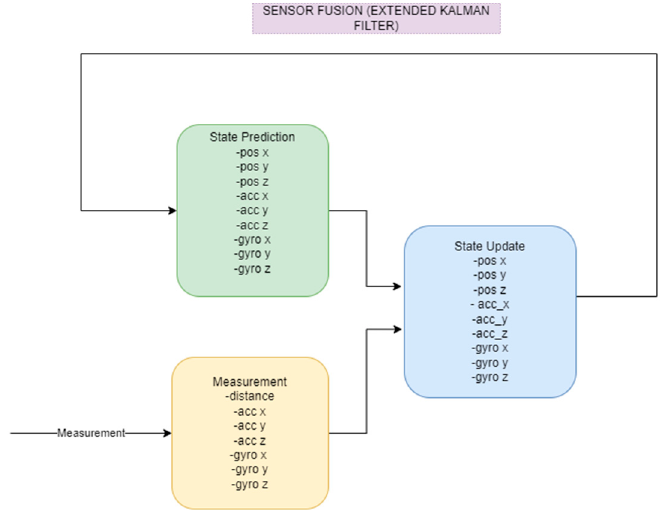
Figure 2. Sensor Fusion (EKF) Structure Schematic.